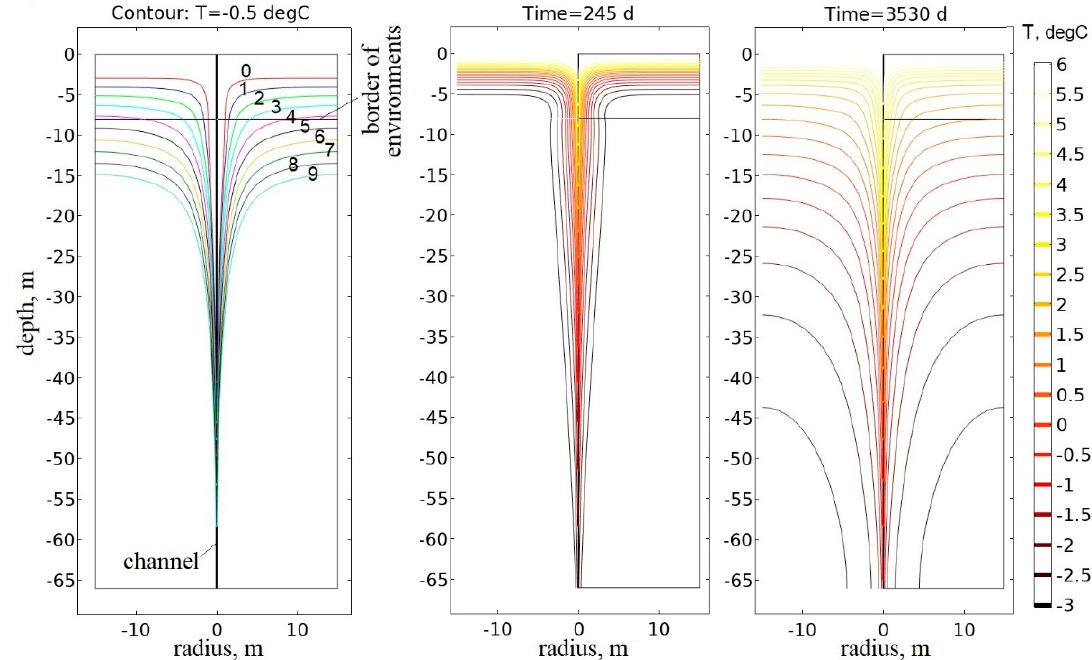
Figure 7. Contour plots of temperature distribution in the frozen rock (well t3) at different points of time. The simulation period is 10 years. The ambient rock temperature is − 4 °C and the velocity of water flowing into the cylindrical channel is 100 m/day.